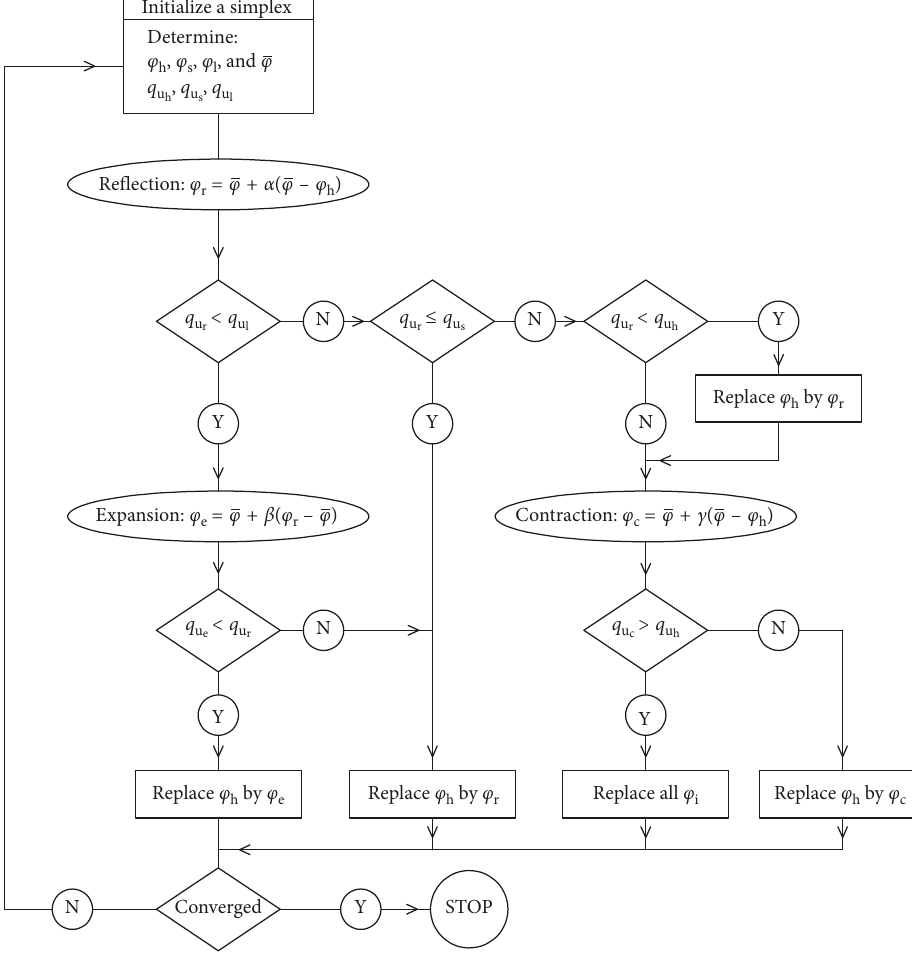
Figure 3: Flowchart of the sequential simplex